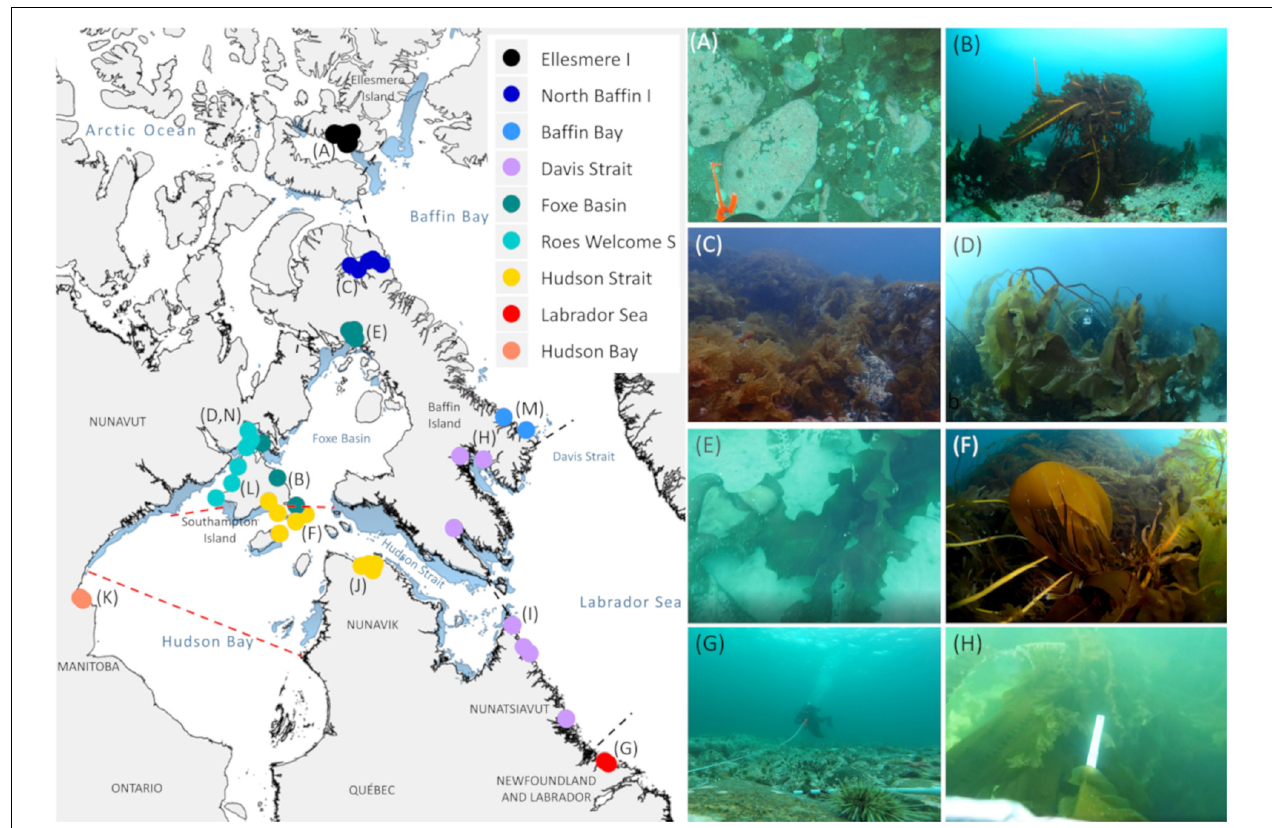
FIGURE 1 | Location of study sites within the Eastern Canadian Arctic. Colors show distinct regions divided by Spalding et al. (2007) classification (dashed black lines) and known oceanographic features (Adey and Hayek, 2011; Brown et al., 2018) (red lines). Light blue shading shows polynya zones (WWF Global Arctic Program). Study site names and coordinates provided in Supplementary Table 1 . Note some points are overlapping. Letters correspond to photographs showing diverse configurations of assemblages across regions. (A) Coralline algae with sea urchins and sparse Agarum clathratum 10 m depth in Ellesmere Island (Starnes Fiord; credit Eric Brossier); (B) Alaria esculenta on sand and pebbles in Foxe Basin (Southampton Island, credit Ignacio Garrido); (C) A. clathratum -dominated bedrock in north Baffin Island (Mittimatalik; credit Karen Filbee-Dexter); (D) “Floating” S. latissima forest rising over diver in Rose Welcome Sound